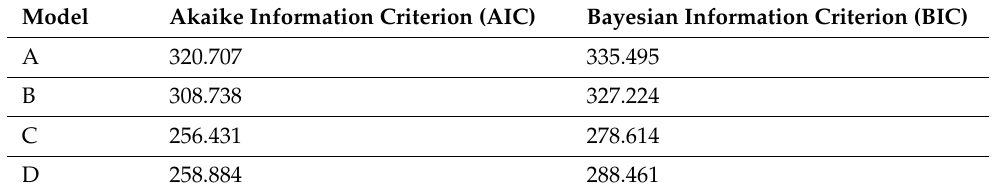
Table A2. Information criteria.